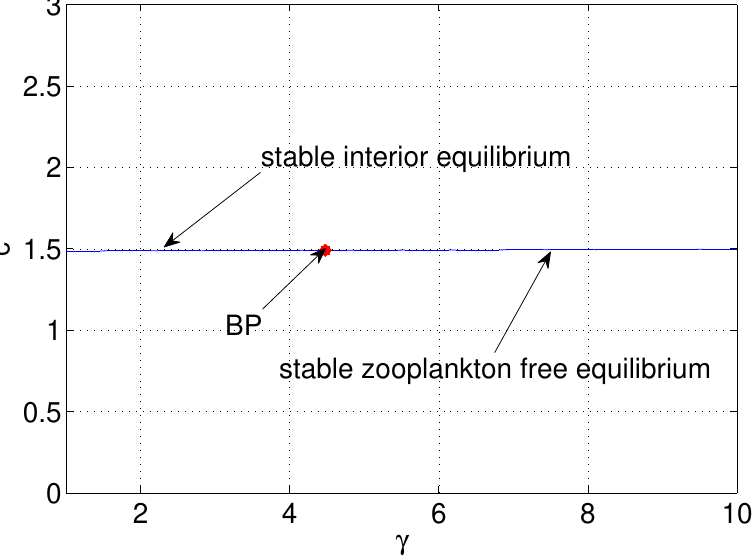
Figure 18. Bifurcation diagram of system (1) taking γ as the bifurcation parameter, while the others remain unchanged, as in Figure 6. Here, ‘BP’ appears at γ = γ [ tc ] =